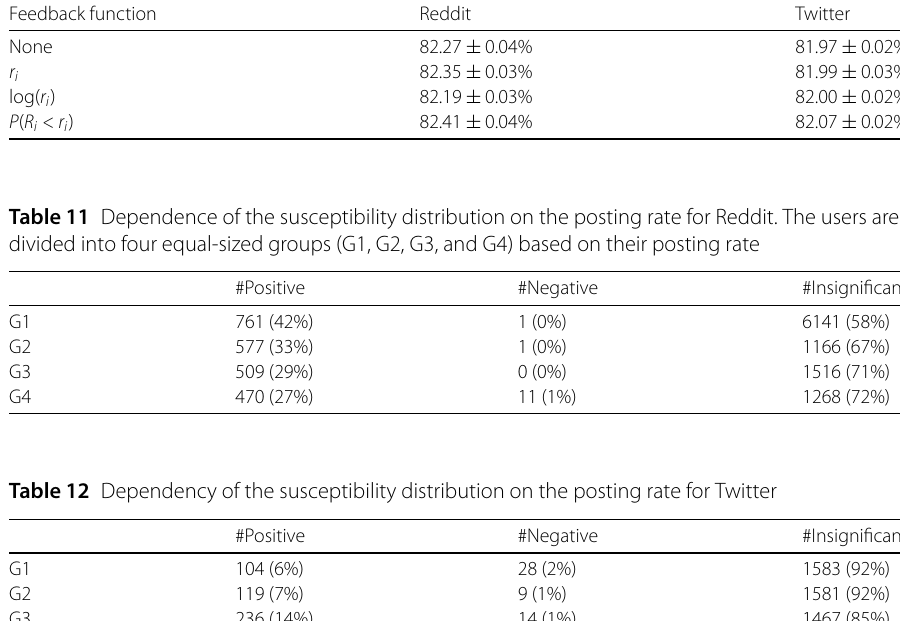
Table 10 The effect of feedback function on the prediction accuracy (the feedback rate x = r i ) Feedback function Reddit Twitter None